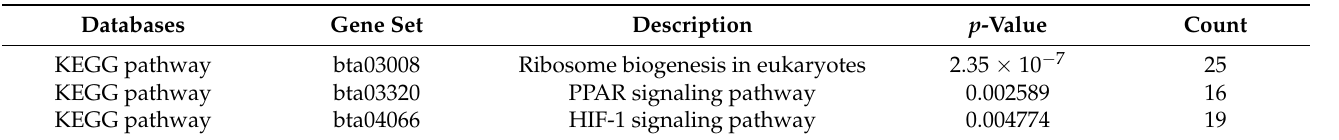
Table 7. KEGG pathway analysis of the maturation- and hypertrophy-related DEGs and proportional p -values identified in Bos taurus .